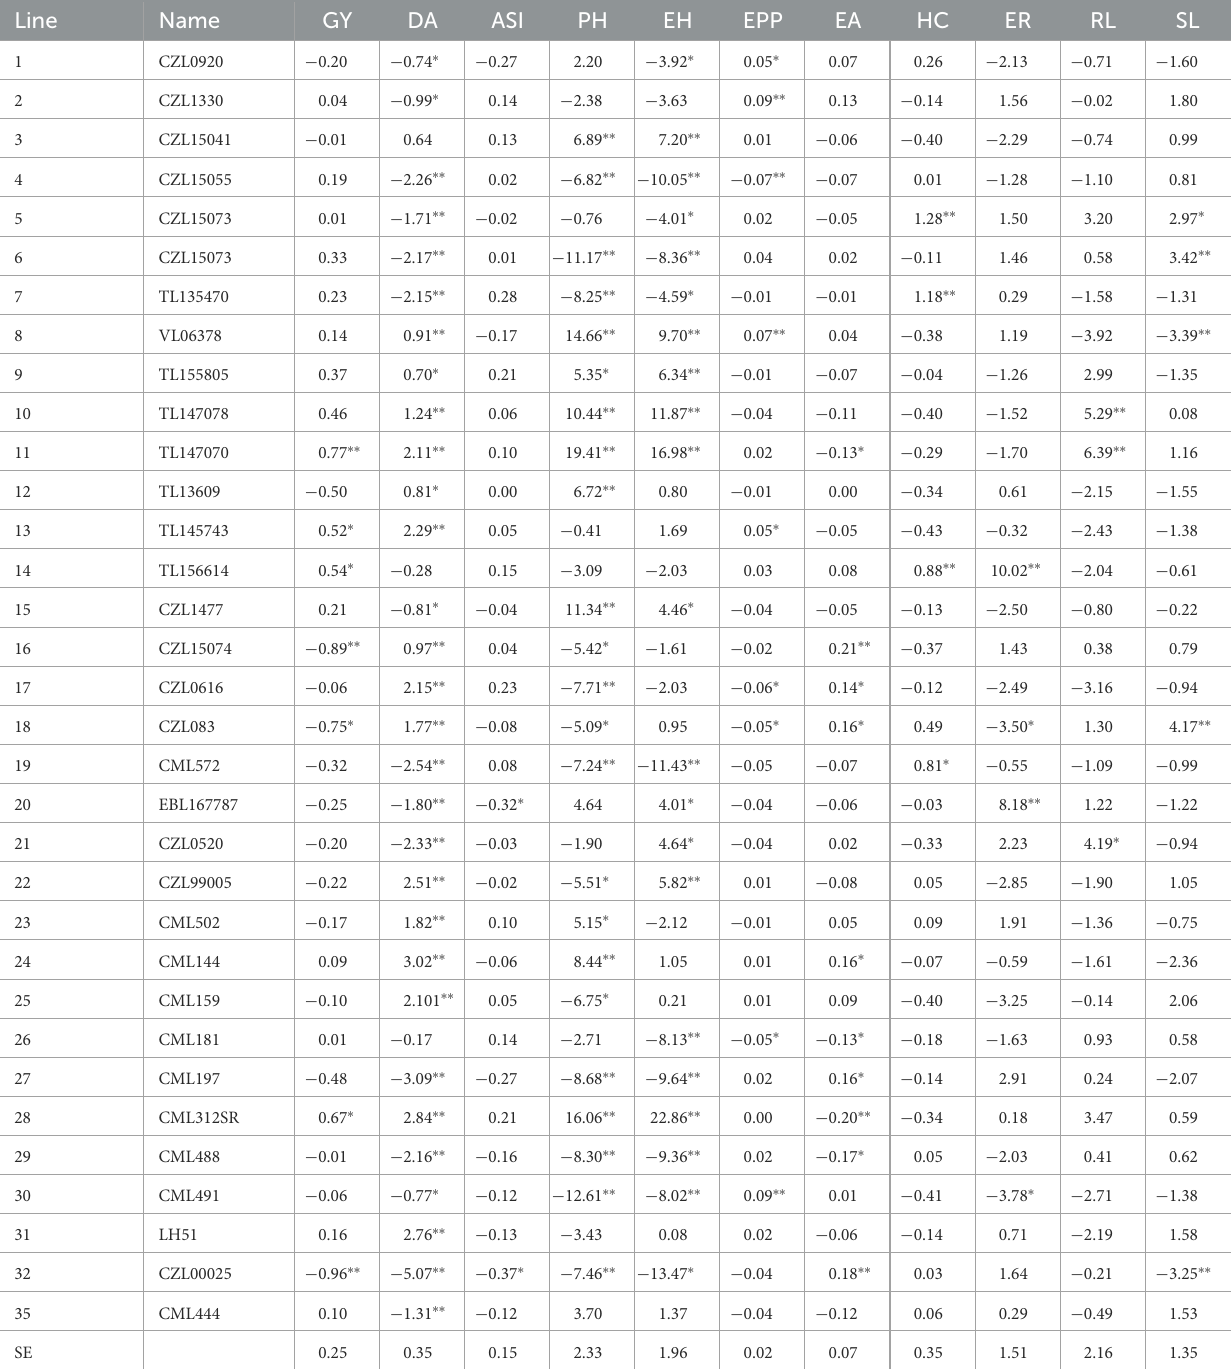
TABLE 3 General combining ability effects of 33 lines for grain yield and other traits evaluated at 13 locations during the 2018 and 2019 seasons in South Africa and Zimbabwe.